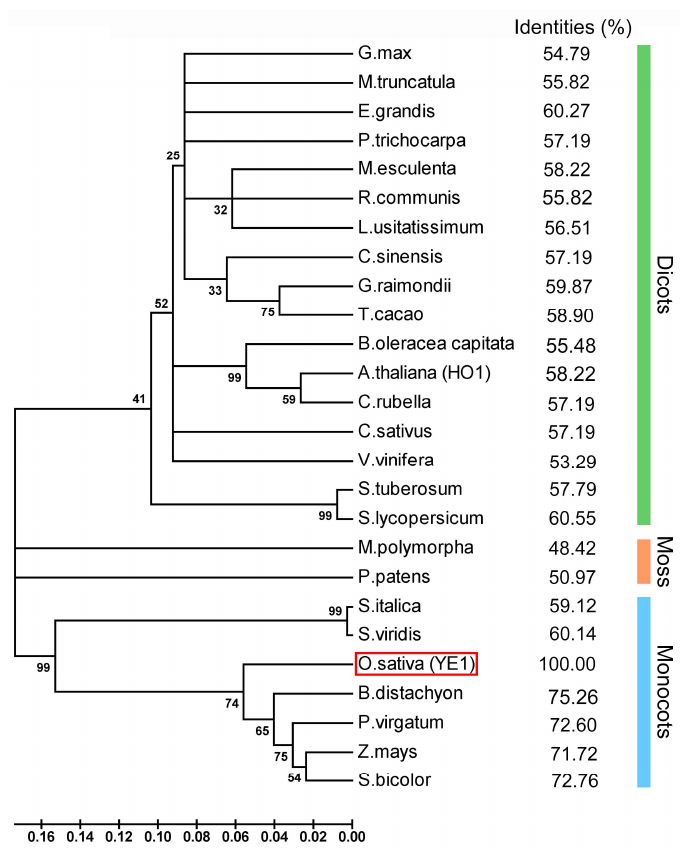
Figure 5. Protein phylogenic analysis among YE1 and YE1-related proteins. A neighbor-joining phylogenic analysis was performed using MEGA 5.0, based on the alignment result in Supplementary Figure S3. The YE1-related proteins are clearly clustered into three clades. Green, orange and blue bars represent the three different clades, which indicate the homologous proteins of YE1 from the species in dicots, moss and monocots, respectively. The YE1 protein is highlighted by the red box. The numbers at the nodes indicate the bootstrap value. The percentage numbers represent the identities of corresponding proteins to YE1.